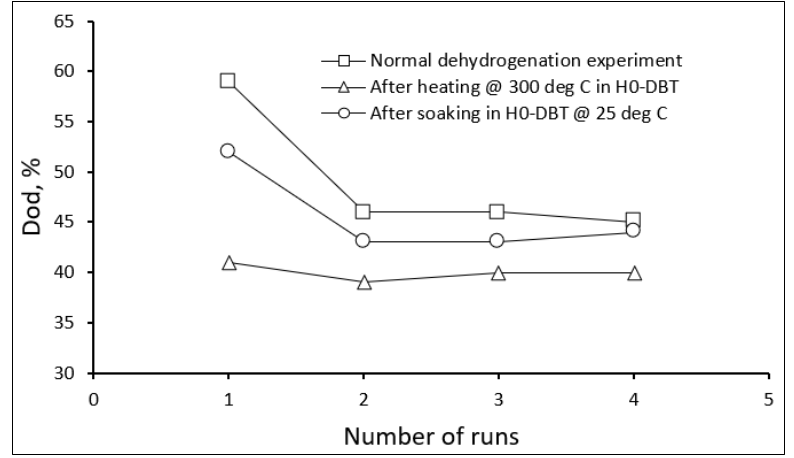
Figure 4. Results of investigation into the effect of the product (H0-DBT) on the catalyst deactivation. Reaction conditions: batch reactor, reaction time 100 min for each run, reaction temperature 300 °C, CAT-A (Pt/Al 2 O 3 ), n Pt /n H18-DBT (99.7 doh) 0.05 mol %.